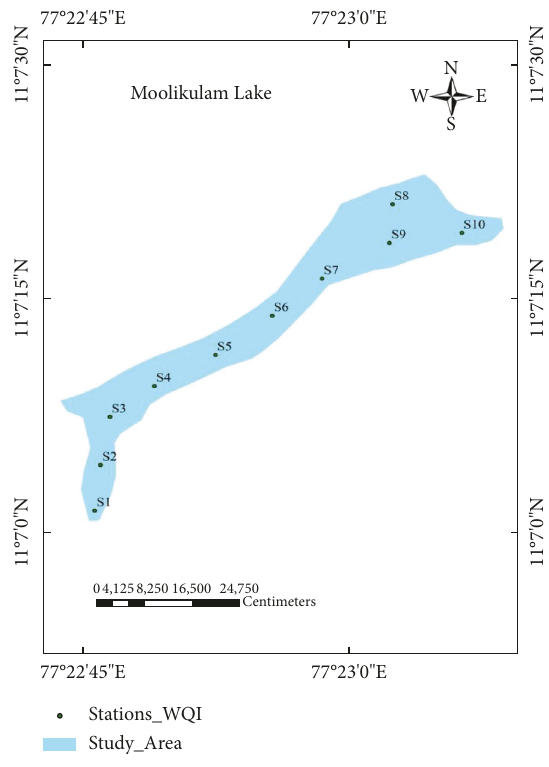
Figure 1: Study area map of Mooli Kulam